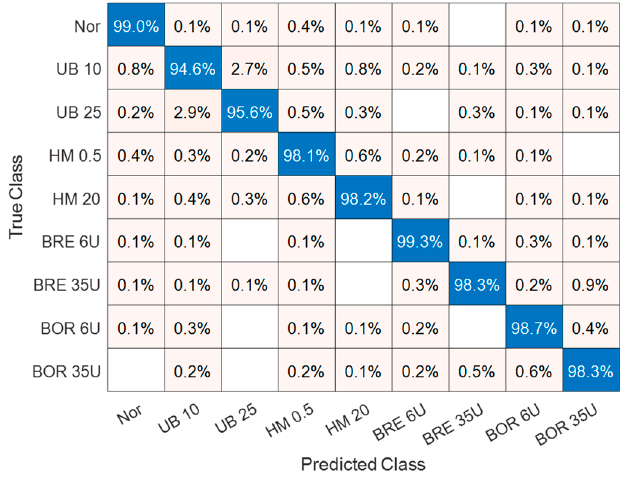
Figure 19. Training/validation confusion matrix of SVM on automatically extracted features through the pretrained deep learning model from the data of the MFS kit.